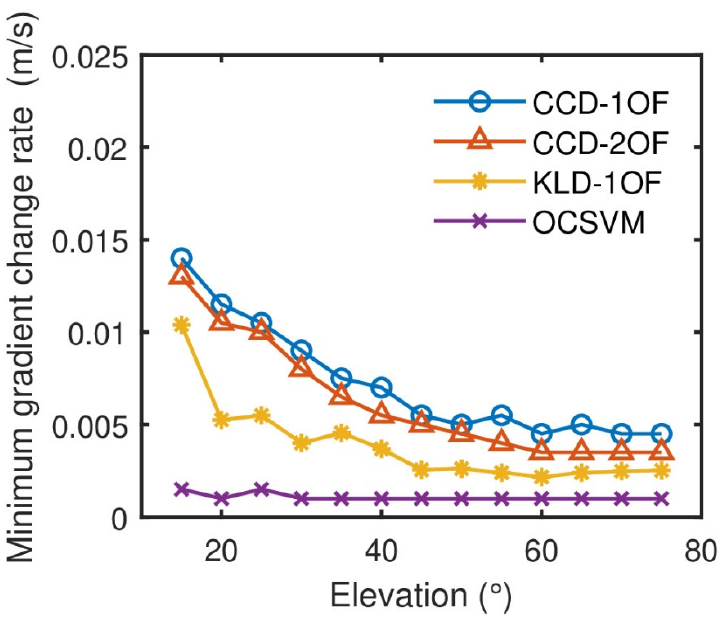
Figure 15. Variations of the minimum gradient changes that can be detected by different monitors in terms of elevations.